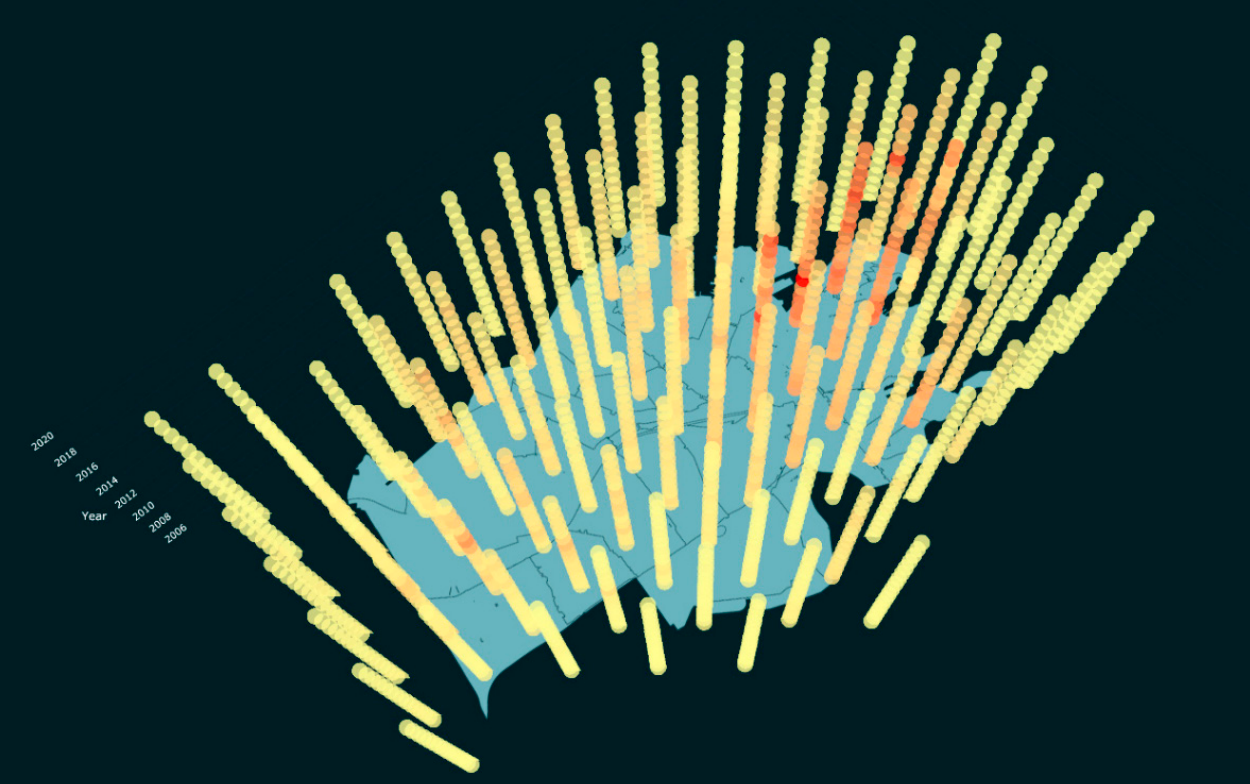
Figure 20. Space time cube analysis of developments over time (2005–2021). Darker dots indicate higher intensity of development activity.